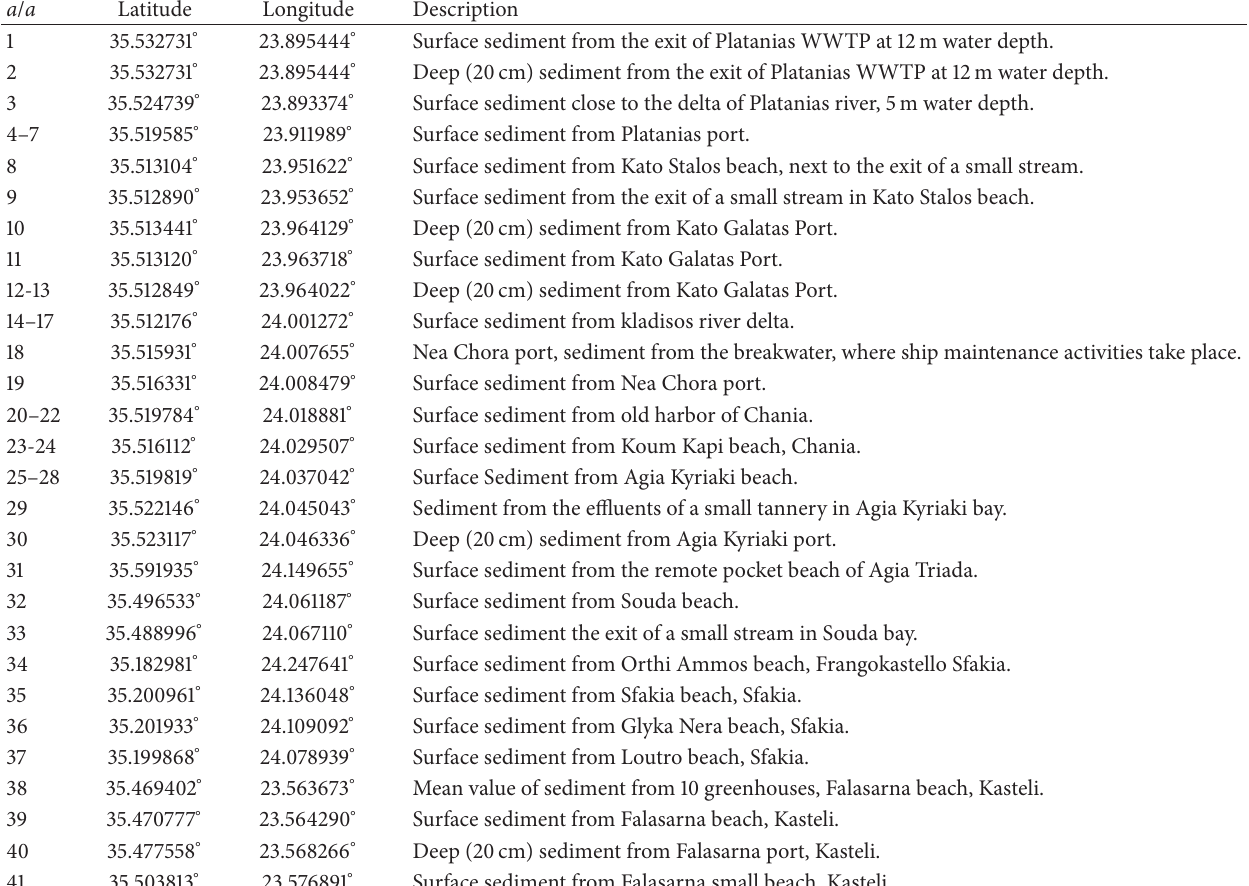
Table 1: The sampling points, their coordinates, and a brief description.